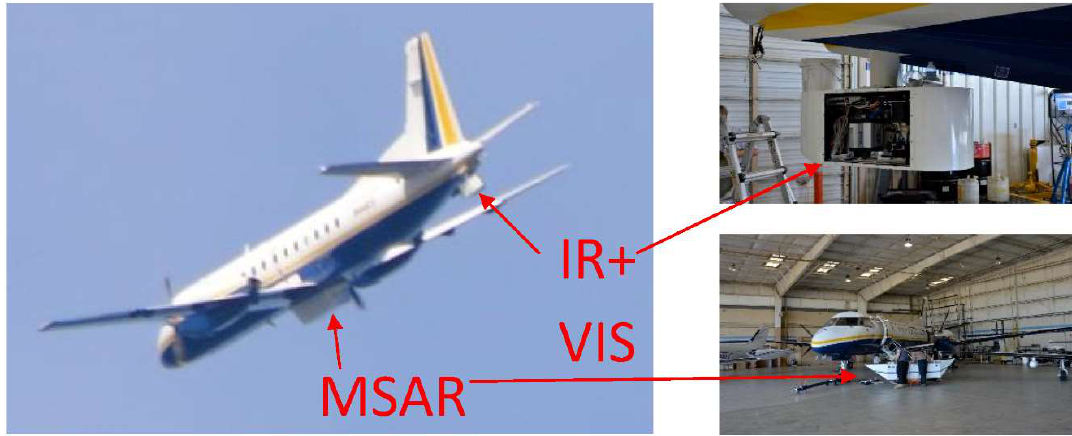
Figure 1. ( left ) Photograph of the remote sensing aircraft SAAB 340 with ( upper right ) infrared and visible sensors enclosure and ( lower right ) MSAR radome.